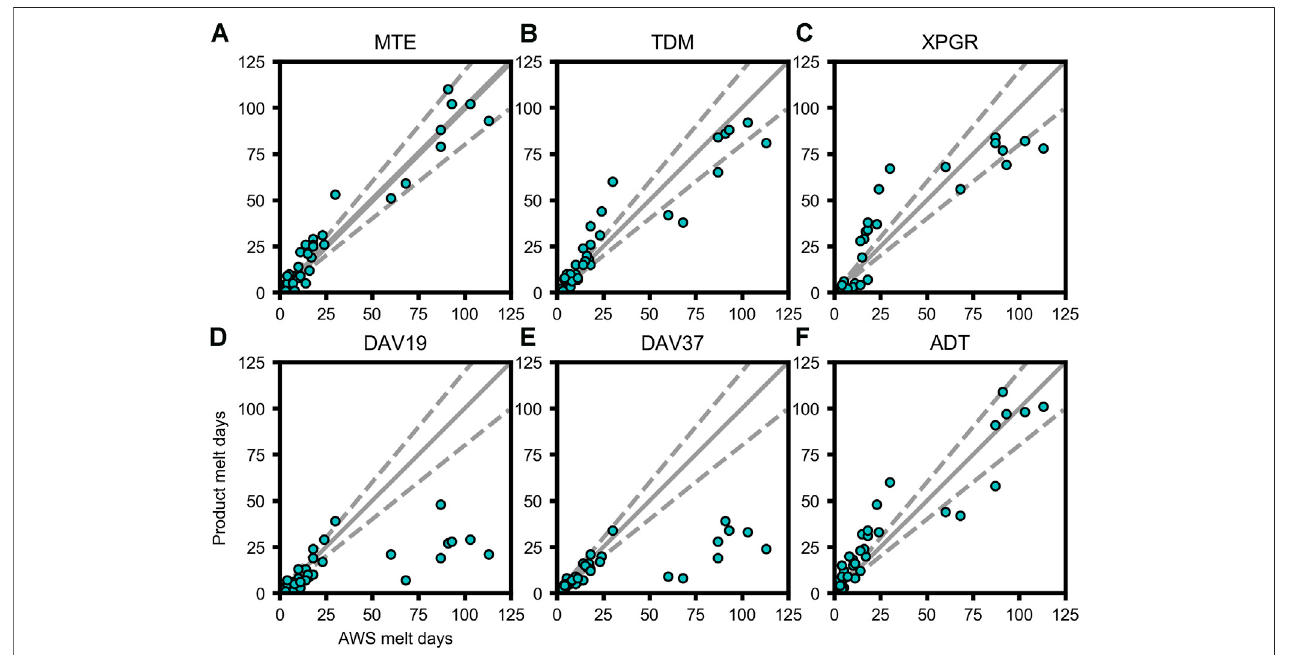
FIGURE4| AnnualmeltdaysfromAWSmeasurements( x -axis)andallsixsatellitemicrowavemeltproducts( y -axis)forallsitesandallyears.Graylineindicatesthe 1:1 relationship, and dashed lines bound the ± 20% envelope for reference.